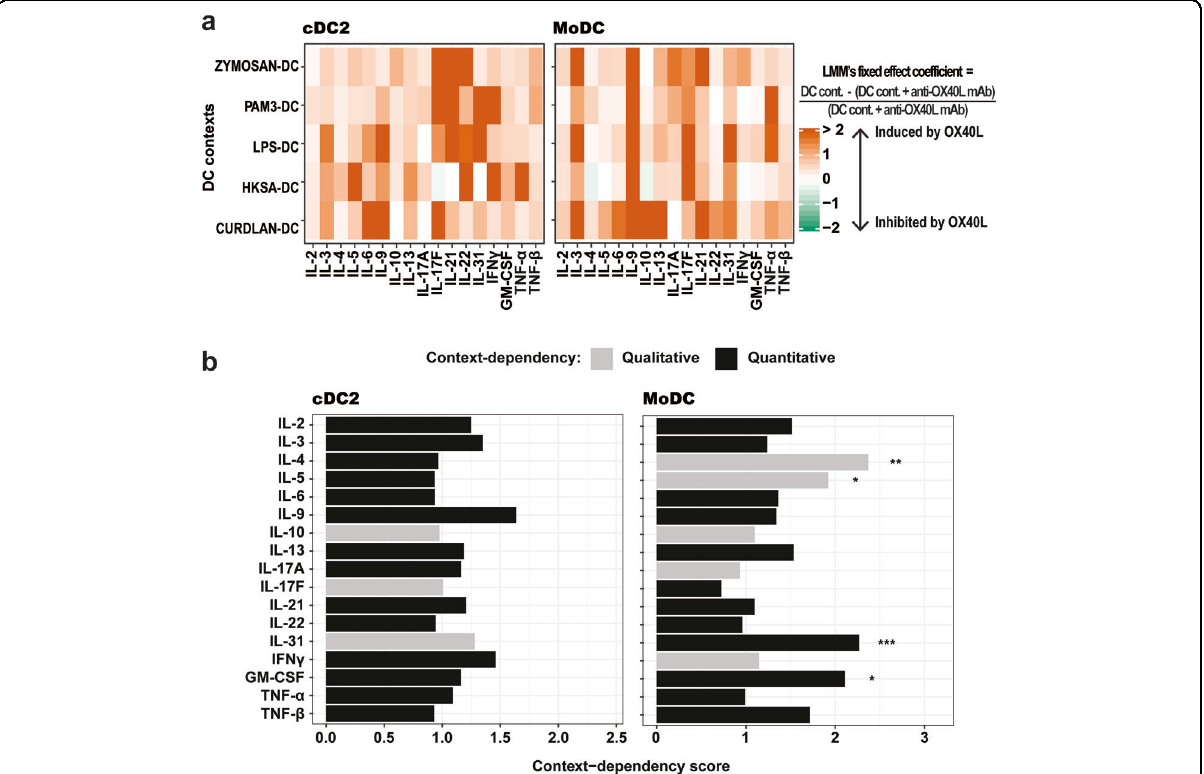
Fig. 6 The cellular context highly impacts OX40L ’ s context-dependent effects on Th cytokine secretion. a Heatmaps representing the estimated OX40L-induced relative difference for the 17 output Th-cytokines measured in each of the fi ve cDC2 and MoDC contexts, calculated using Linear Mixed-effects Models. The estimated coef fi cients for the fi xed effects from the models are represented. For a given cytokine, with a given DC type and in a given DC stimulus, the LMM ’ s coef fi cient corresponds to the mean over donors of the concentration in the presence of the isotype (DC cont.) subtracted by the concentration in the presence of anti-OX40L antibody (DC cont. + anti-OX40L mAb), divided by the concentration in the presence of anti-OX40L antibody (DC cont. + anti-OX40L mAb). b Scoring of the context-dependency across the fi ve cDC2 and MoDC contexts. Black bars represent a quantitative OX40L context-dependency, meaning the variation of a considered output cytokine in one direction (increase or decrease) in all the cDC2 or MoDC contexts in the presence of OX40L. Grey bars indicate a qualitative OX40L context-dependency, meaning variation of an output cytokine in the opposite direction in at least one cDC2 or MoDC context due to the presence of OX40L. Likelihood ratio tests were used to evaluate the signi fi cance of the context-dependency. * P ≤ 0.05; ** P ≤ 0.01; *** P ≤